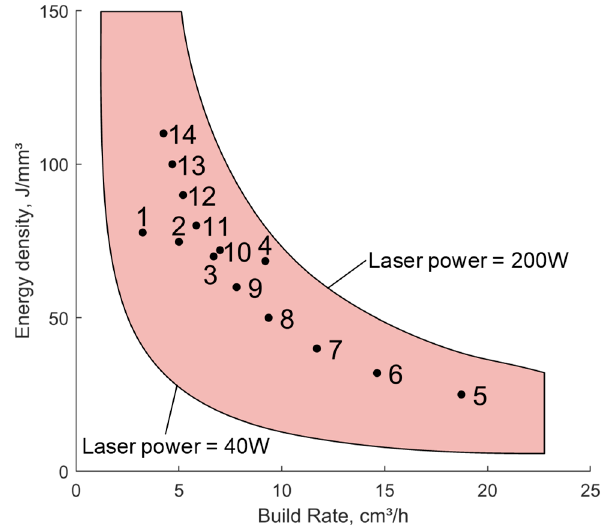
Figure 1. Energy density–build rate window with processing conditions of 14 Ti-18Zr-14Nb calibration specimens ( TruPrint 1000 ). Table 1. Processing parameters for 14 Ti-Zr-Nb calibration specimens (constant layer thickness of t = 30 μ m).